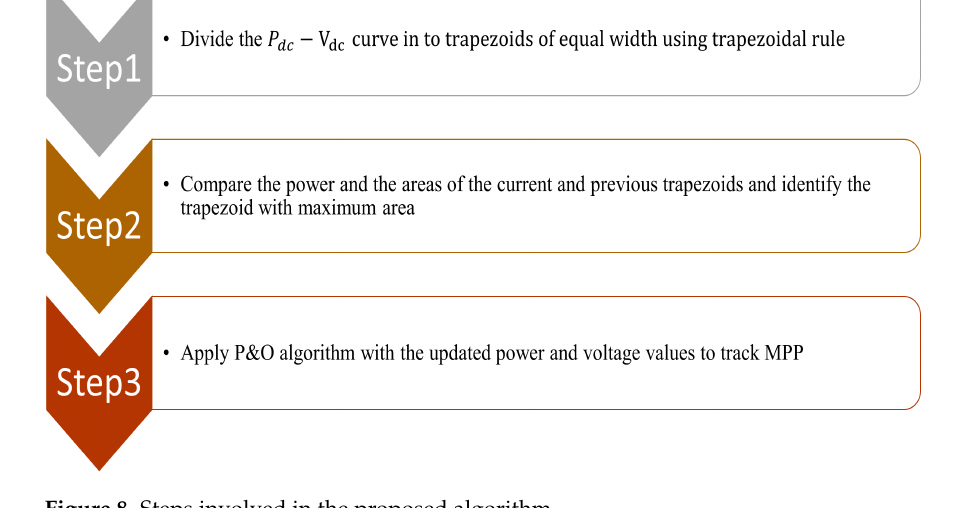
Figure 8. Steps involved in the proposed algorithm.